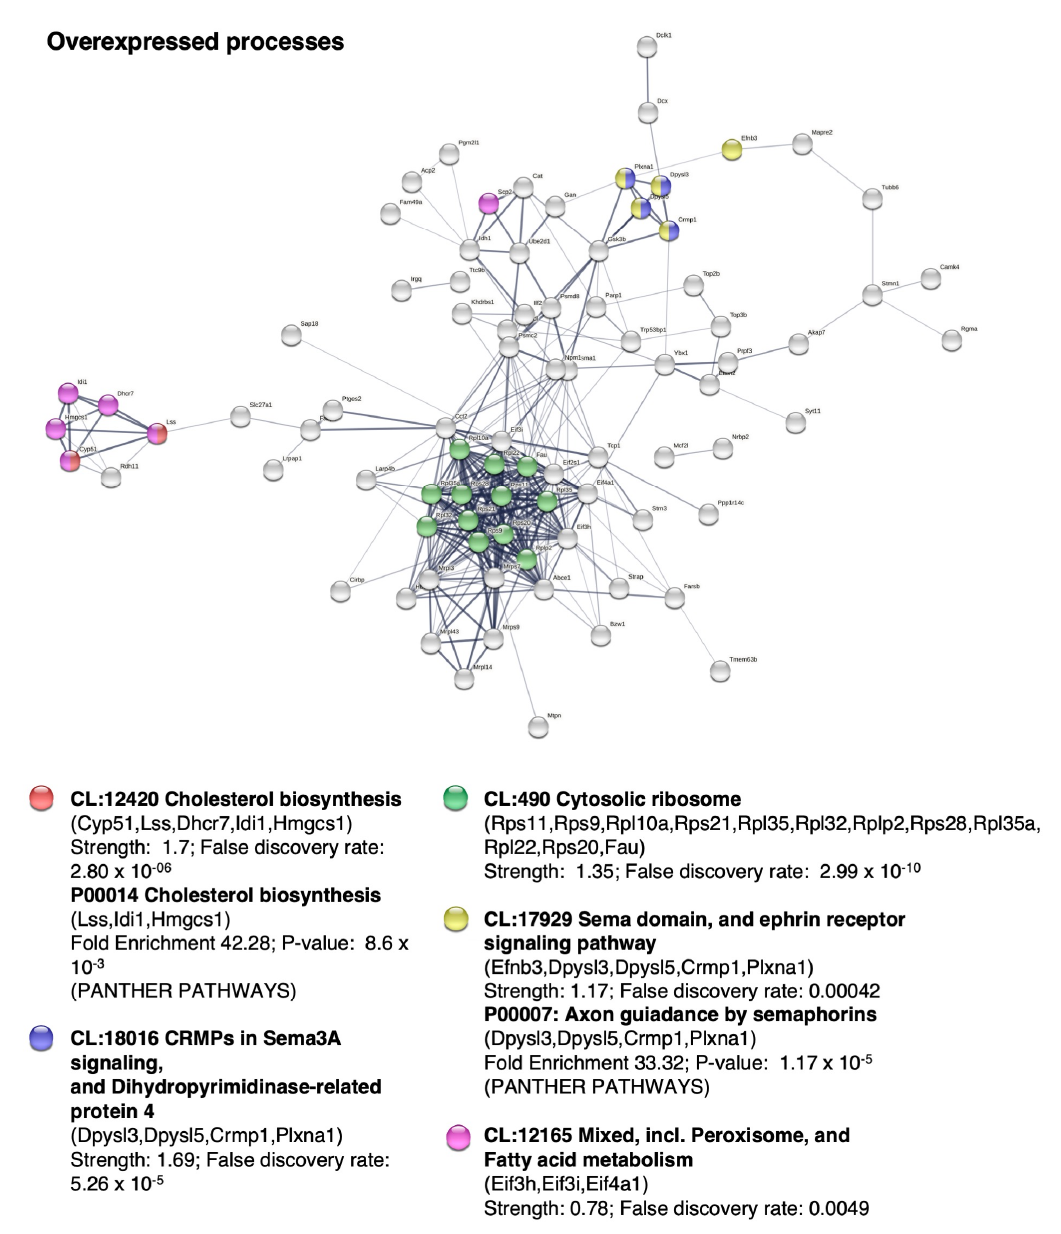
Figure 4. Gene Ontology and STRING analysis of the overexpressed proteins between BM-MSC- transplanted and sham-injected hydrocephalic hyh mice. Analysis and representation with STRING comparing the BM-MSC-transplanted (n = 8) hydrocephalic hyh mice with the sham-injected hy- drocephalic hyh mice (n = 6) at P18. The analysis resulted in the categorization of proteins into various groups based on biological processes (GO, GO-Slim biological processes in PANTHER; P, PANTHER PATHWAYS) and local network clusters (CL, STRING). The percentage of genes against the total number of genes in the list is indicated. Reference gene expression corresponds to proteins found in the sham-injected mice. In PANTHER, fold enrichment represents the number of genes whose expression changed over the expected expression. A binomial test with Bonferroni correction for mul- tiple testing with p < 0.05 was applied. In STRING, strength represents Log10 (observed/expected). This measure describes how large the enrichment effect is. It is the ratio between (i) the number of proteins in the network that are annotated with a term and (ii) the number of proteins that are expected to be annotated with this term in a random network of the same size. False discovery rate describes how significant the enrichment is. The p values corrected for multiple testing within each category using the Benjamini–Hochberg procedure are